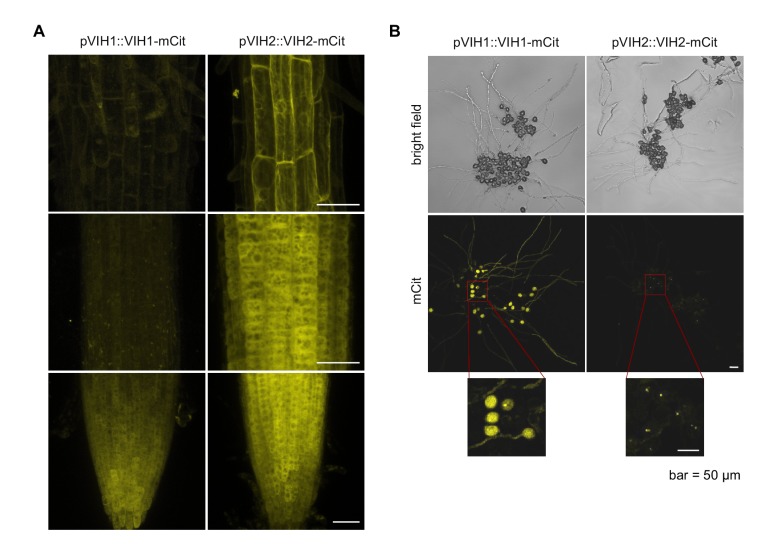
VIH1 and VIH2 are cytoplasmic enzymes with partially overlapping expression domains.Stacked slices of (A) confocal scanning microscopy images showing the root tip of transgenic Arabidopsis plants expressing pVIH1::VIH1-mCit (left) and pVIH2::VIH2-mCit (right) in the vih1-2 and vih2-4 background, respectively. (B) Confocal scanning microscopy images of pollen and pollen tubes from the plants shown in (A), incubated for 4 hr on agarose plates containing 5 mM CaCl2, 5 mM KCl, 1 mM MgSO4, 0.01% (w/v) H3BO4 and 10% (w/v) sucrose, and 1.5% (w/v) agarose pH 7.5. Similar localization and expression patterns were observed in at least three independent transgenic lines. Scale bars = 50 μm.